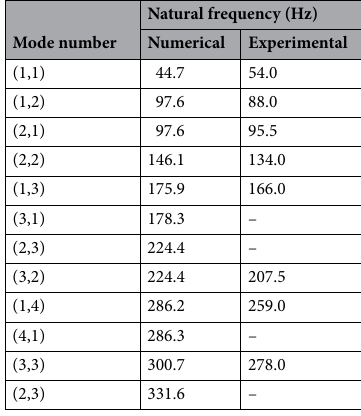
Table 2. Comparison between the natural frequency obtained numerically and experimentally with CCCC boundary